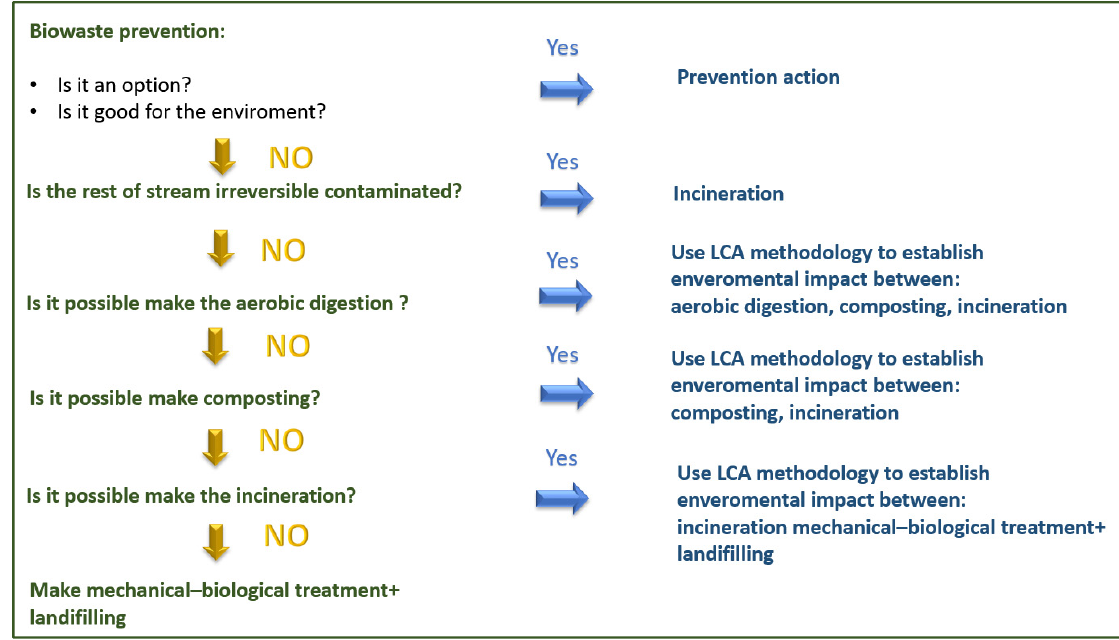
Figure 2. List of guidelines to make valid environmental decisions for the management of organic waste .